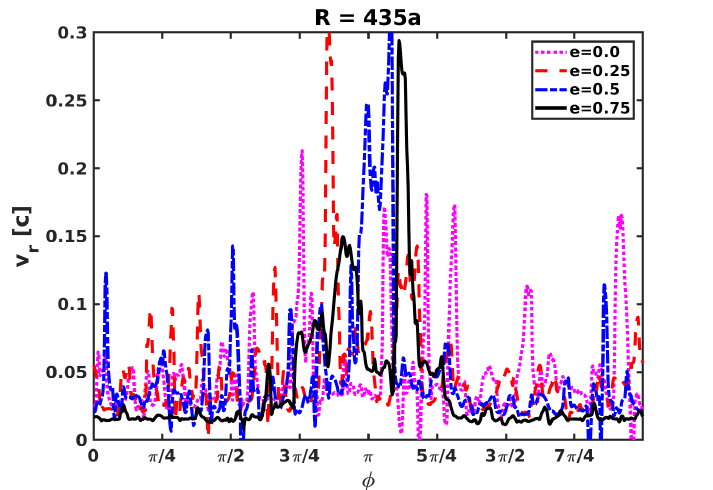
Figure 10. Radialvelocity, averagedover R intheinterval [ 350 a ,435 a ] , versus φ